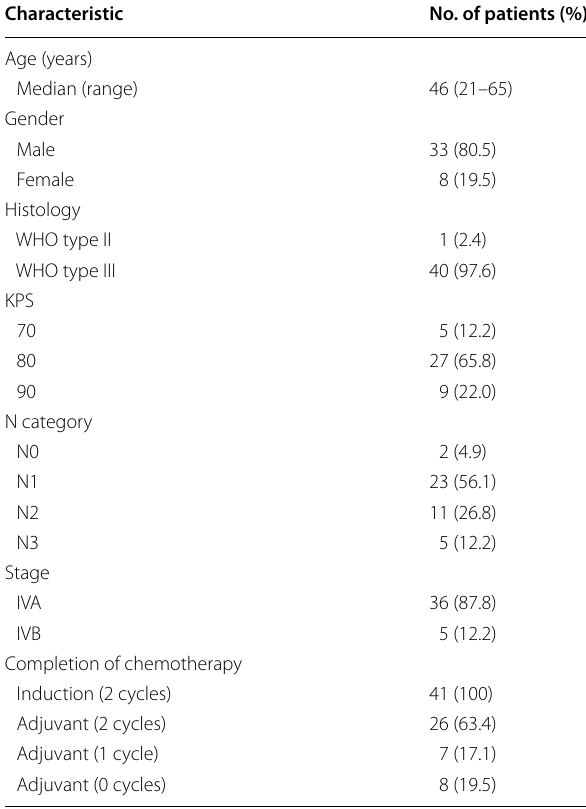
Table 1 Characteristics of T4 NPC patients with intracra- nial extension who were treated with IMRT plus